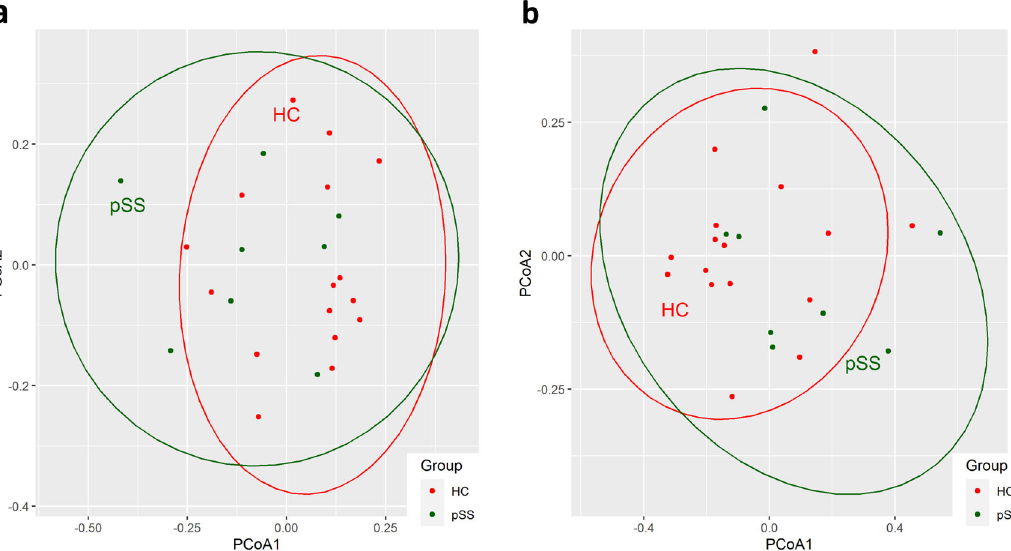
Fig. 1 Principle coordinate analysis at the genus and species levels. Saliva samples from pSS patients (green) and healthy controls (red) could not be distinguished based on the microbiota at the a genus level and b species level. The distance matrix was computed using Euclidean